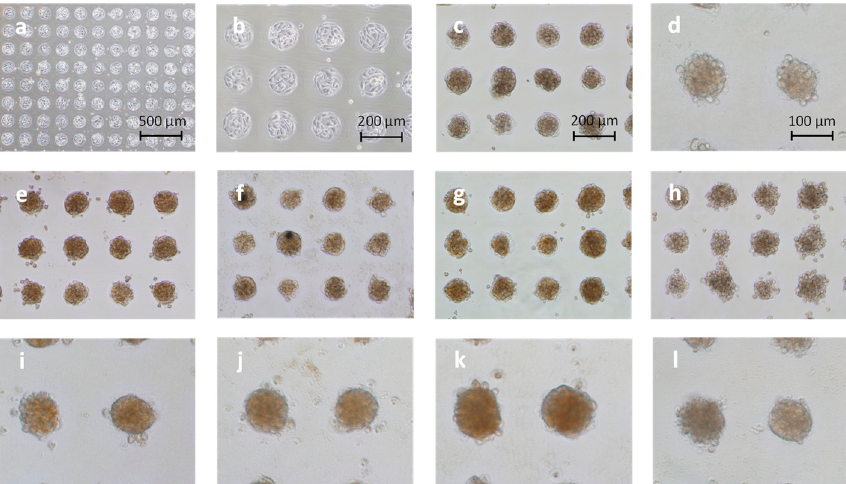
Figure 2. Morphology of 3D liver spheroids labeled with polysaccharide magnetic iron oxide nanoparticles. Endothelial cells (3 × 10 5 ) were inoculated for 24 h onto a Cell‑able 12‑well plate ( a , b ). Hepatocytes were seeded (4 × 10 5 /well) and cultured for 48 h on the endothelial monospheroids. After 48 h of cell culture, hepatocyte–endothelial cell heterospheroids were incubated with 60 μ g‑Fe/mL various nanoparticles in a culture medium for 24 h at 37 °C. The type of nanoparticle: Control (non-labeled) ( c , d ); TMADM ( e , i ); EADM ( f , j ); ATDM ( g , k ); CMDM ( h , l ). Scale bar: 500, 200, and 100 μ m.